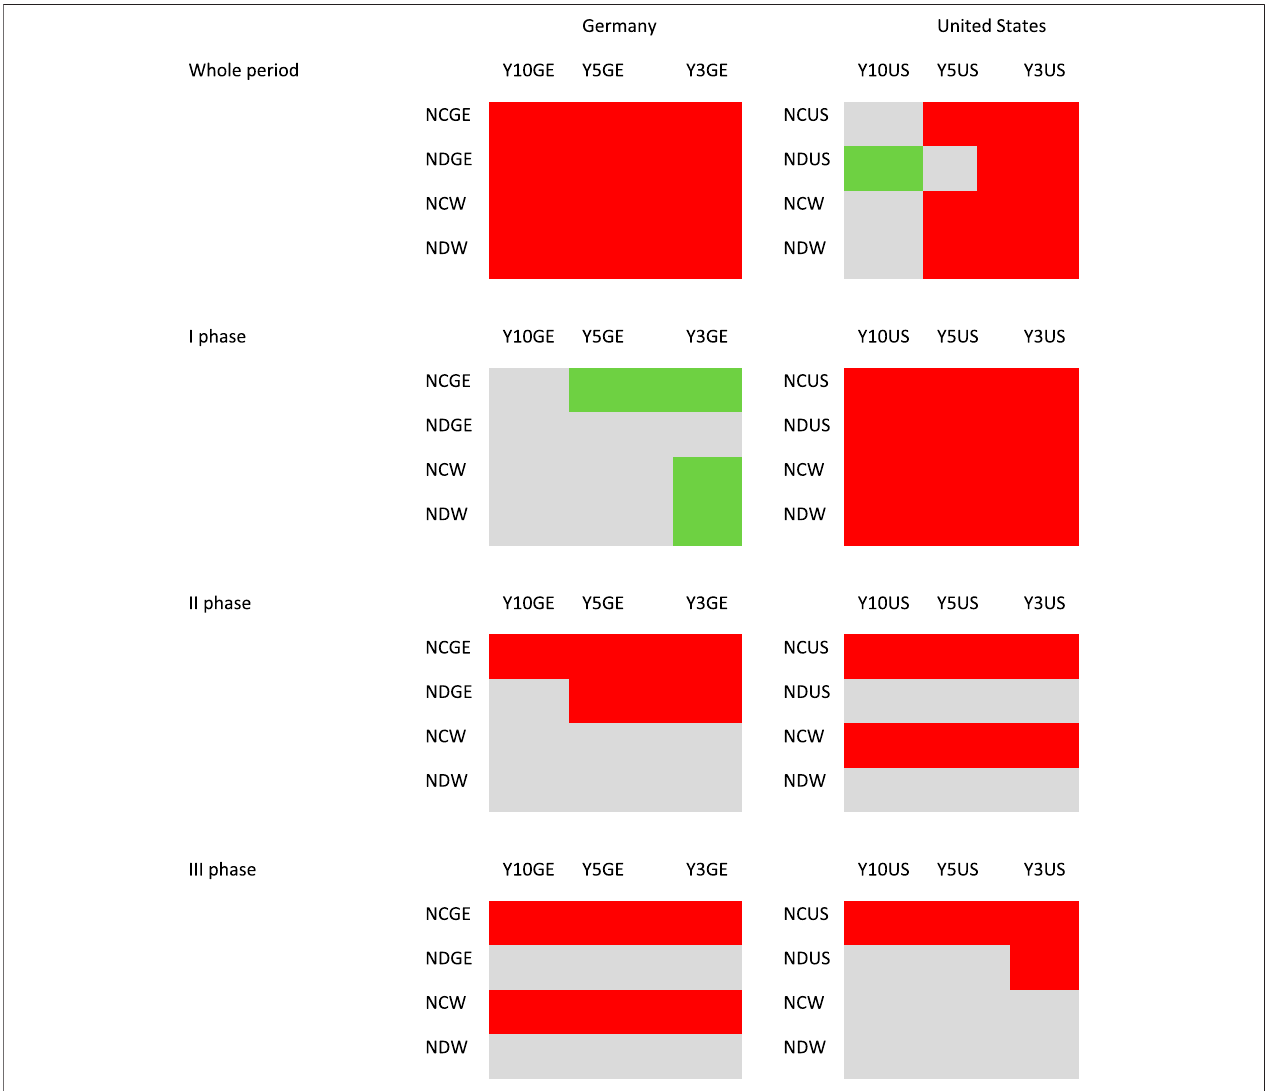
FIGURE 3 | Summary of the results of the COVID-19 pandemic impact on selected countries ’ government bond yields of different maturities in different periods.Note: Whole period = 2020/1/02-2021/03/19; I Phase = 2020/1/02-2020/04/30; II Phase = 2020/05/01-2020/09/30; III Phase = 2020/10/1-2021/03/19; for variable abbreviations see Table 1